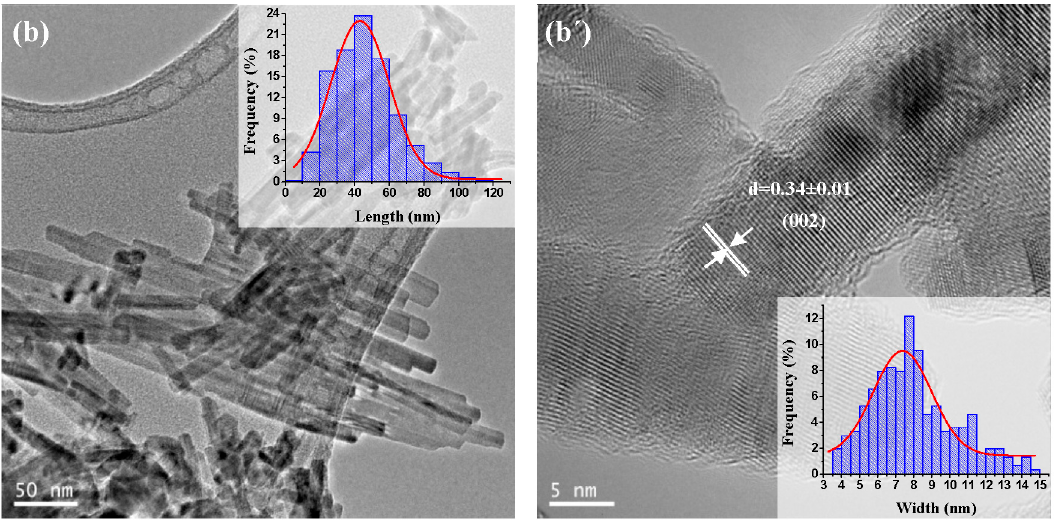
Figure 6. TEM and HRTEM images and size distribution curves (inset) of CdS samples prepared with different H 2 O/thiourea ratio: ( a , a’ ) CdS-1.3 and ( b , b’ ) CdS-3.0.